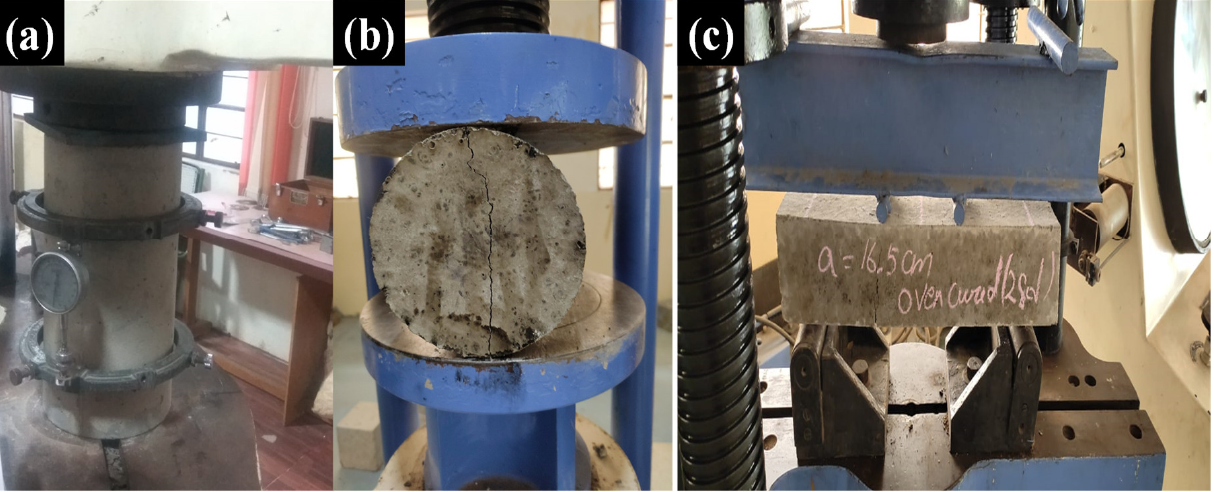
Figure 2. Images of ( a ) CS, (b) TS, and ( c ) FS tests of concrete.